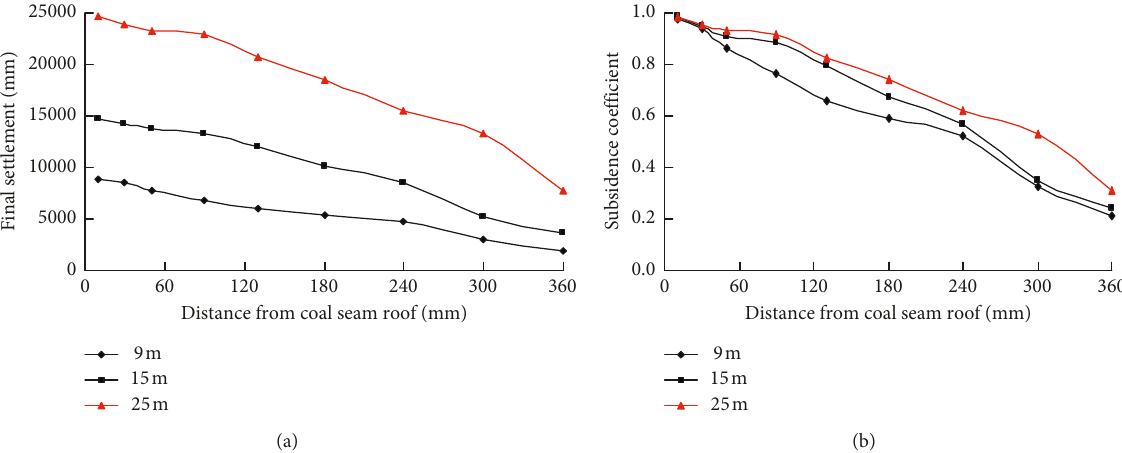
Figure 11: The subsidence variation law curves of overlying strata in different thick coal seams. (a) The final settlement curves of overlying strata with different mining thicknesses. (b) The subsidence coefficient curve of overlying strata with different mining